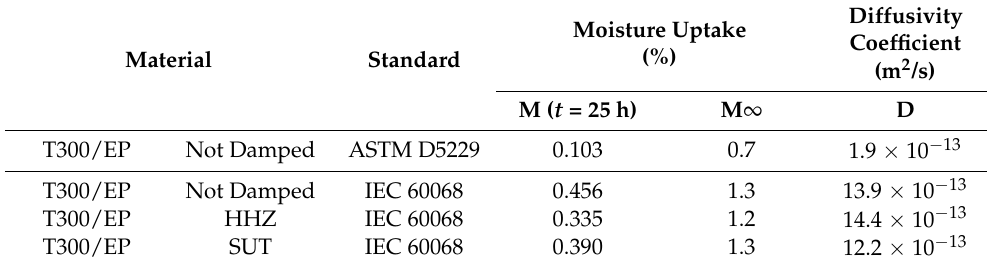
Table 3. Moisture uptake and coefficient of diffusivity for T300/EP composites and damped